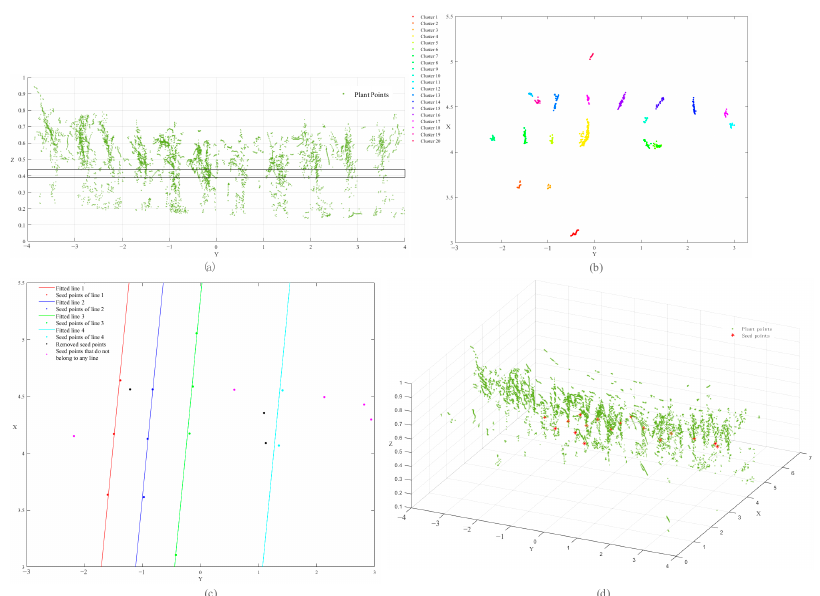
Figure 7. An example of a seed point extraction method. ( a ) Points after surface filtering. ( b ) Slicing and clustering results. ( c ) Planting line fitting and outlier points filtering. ( d ) Superposition of fitting results on origin data. In the figure, “Cluster n” is simply represented as Cn, “Fitted Line n” as FL n, “Seed points of line n” as SPL n, “Removed seed points” as RSP, “Seed points that do not belong to any line” as SPNL.